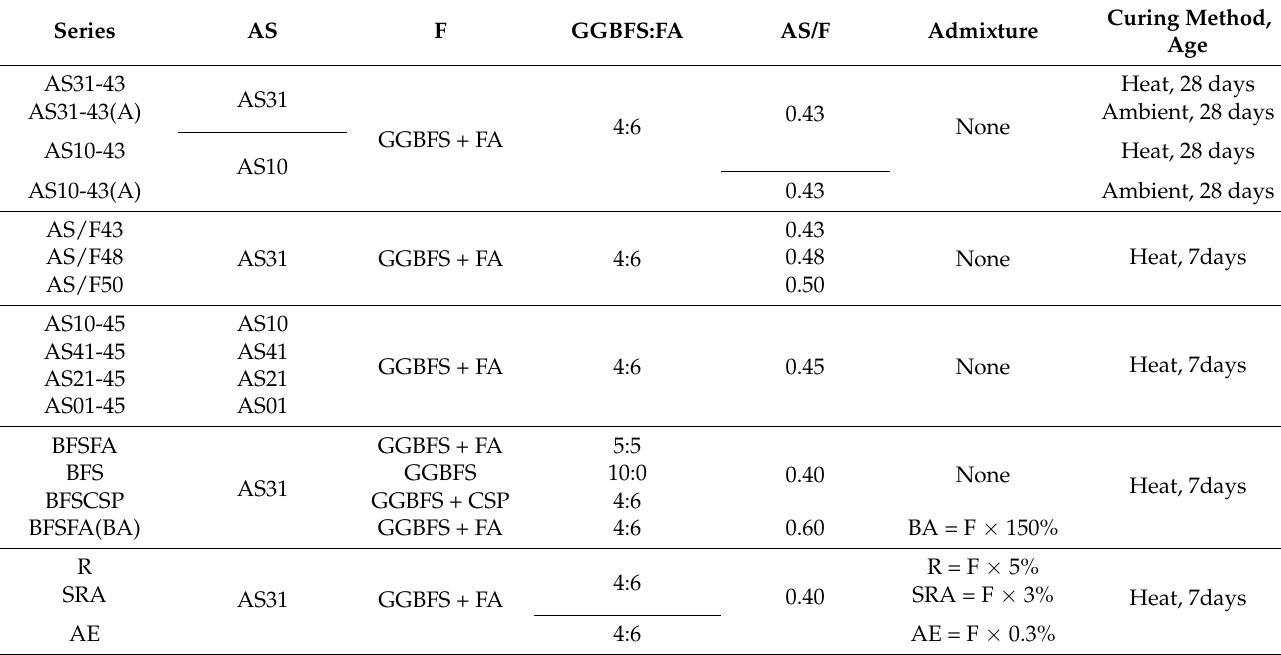
Table 3. Mix proportions of AAFS materials (by